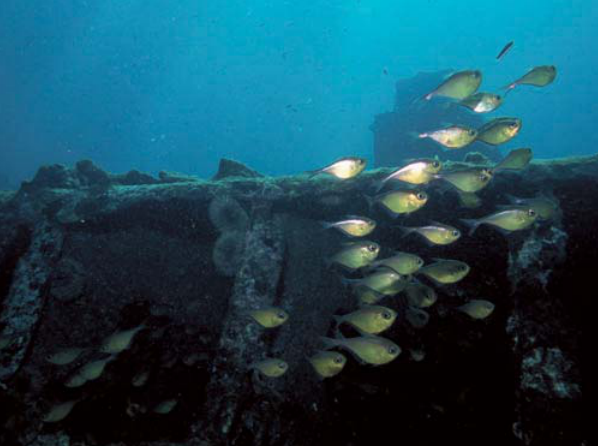
Fig. 3. A small group of glassy sweepers ( Pempheris schomburgki ) leaving their daytime shelter and streaming towards a small Noronha wrasse ( Thalassoma noronhanum ) individual (elongate fish on upper right side) to